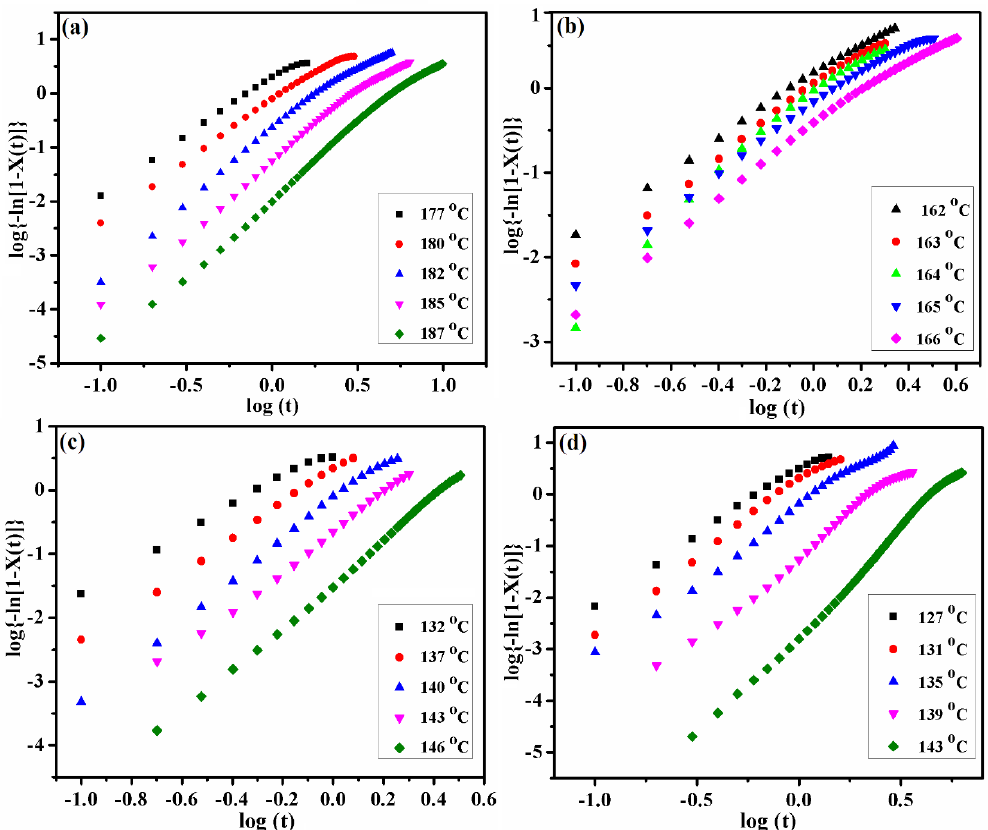
Figure 8. Avrami plots of log {− ln [ 1 − X ( t )] } vs. log t for isothermal crystallization of virgin ( a ) PA6, ( b ) PA6-BABA/SA 30 , ( c ) PA6-BABA/SA 50 , and ( d ) PA6-BABA/SA 70 at T iso .